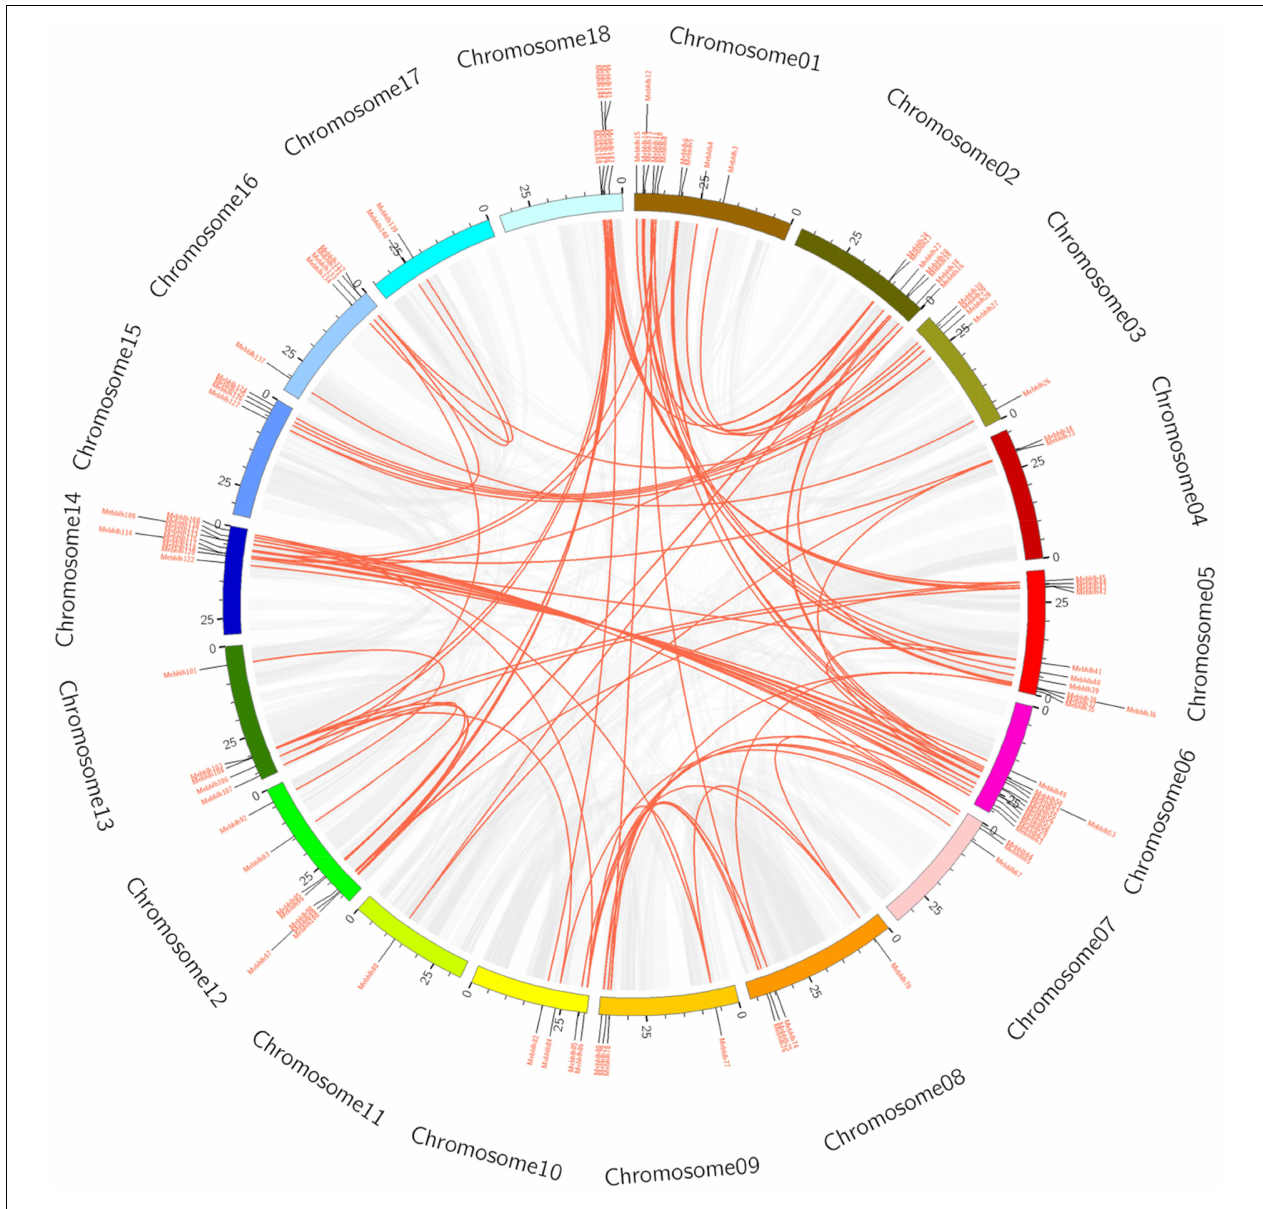
FIGURE 3 | Circos diagram of the MebHLH duplication pairs in M. esculenta . MebHLH duplication pairs are linked with red lines. Scale bar marked on the chromosome indicating chromosome lengths